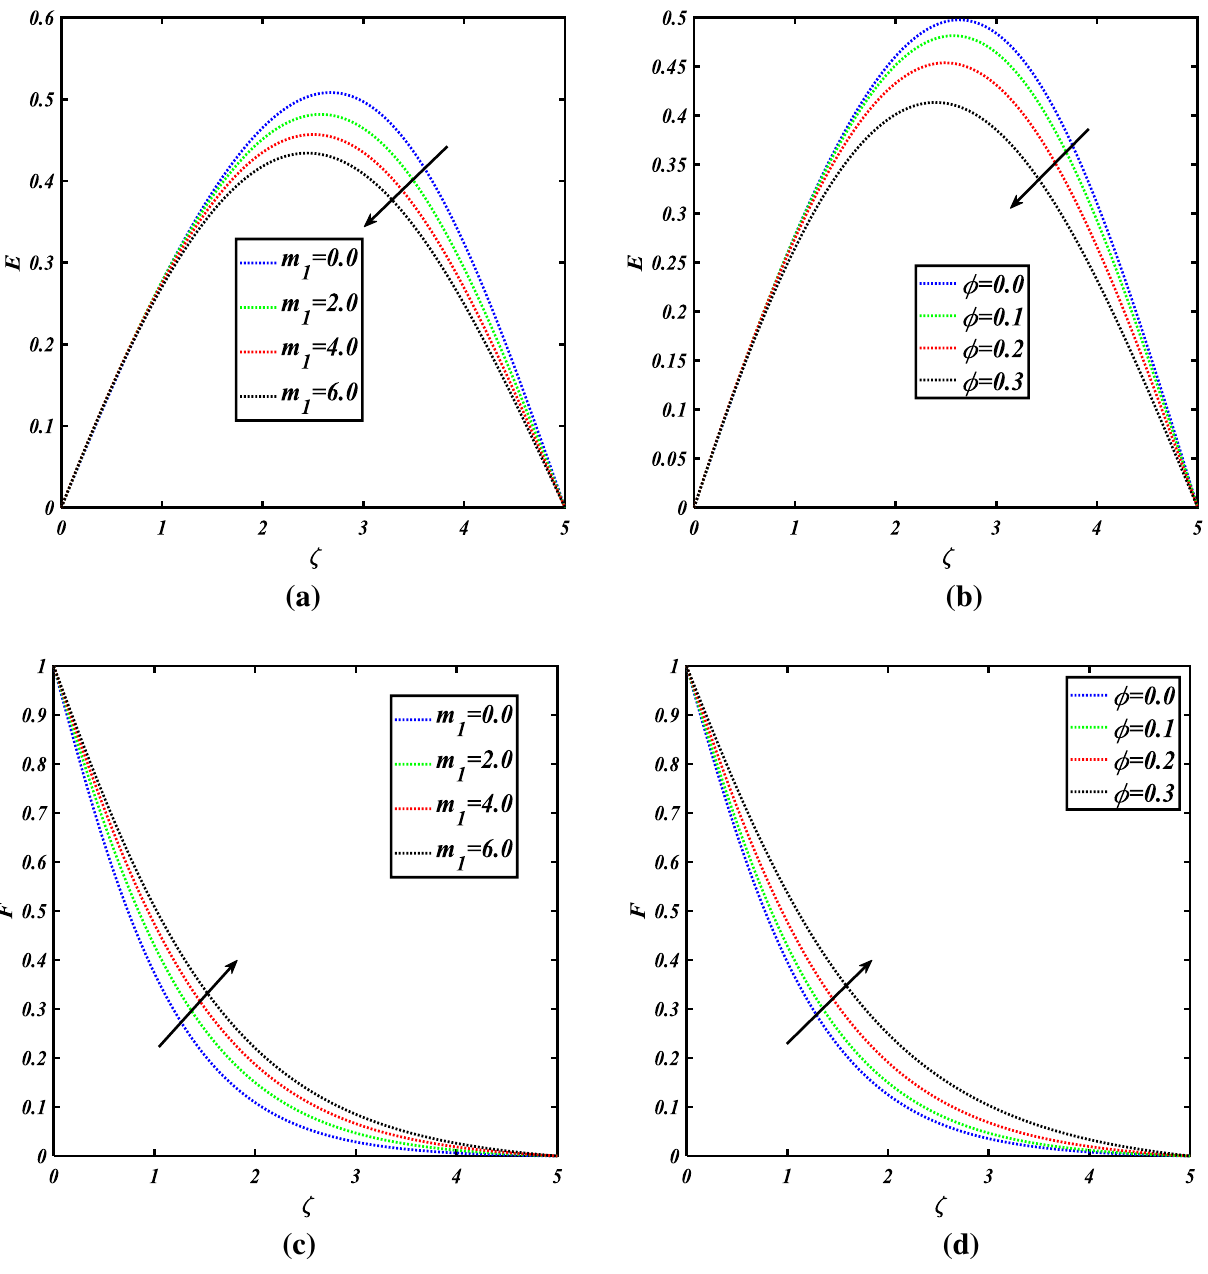
Figure 8. (a) Radial velocity for the values of m 1 , (b) radial velocity for the values of φ , (c) tangential velocity for values of m 1 , (d) tangential velocity for values of φ , (e) axial velocity for the values of m 1 , (f) axial velocity for the values of φ , (g) the effects of a line